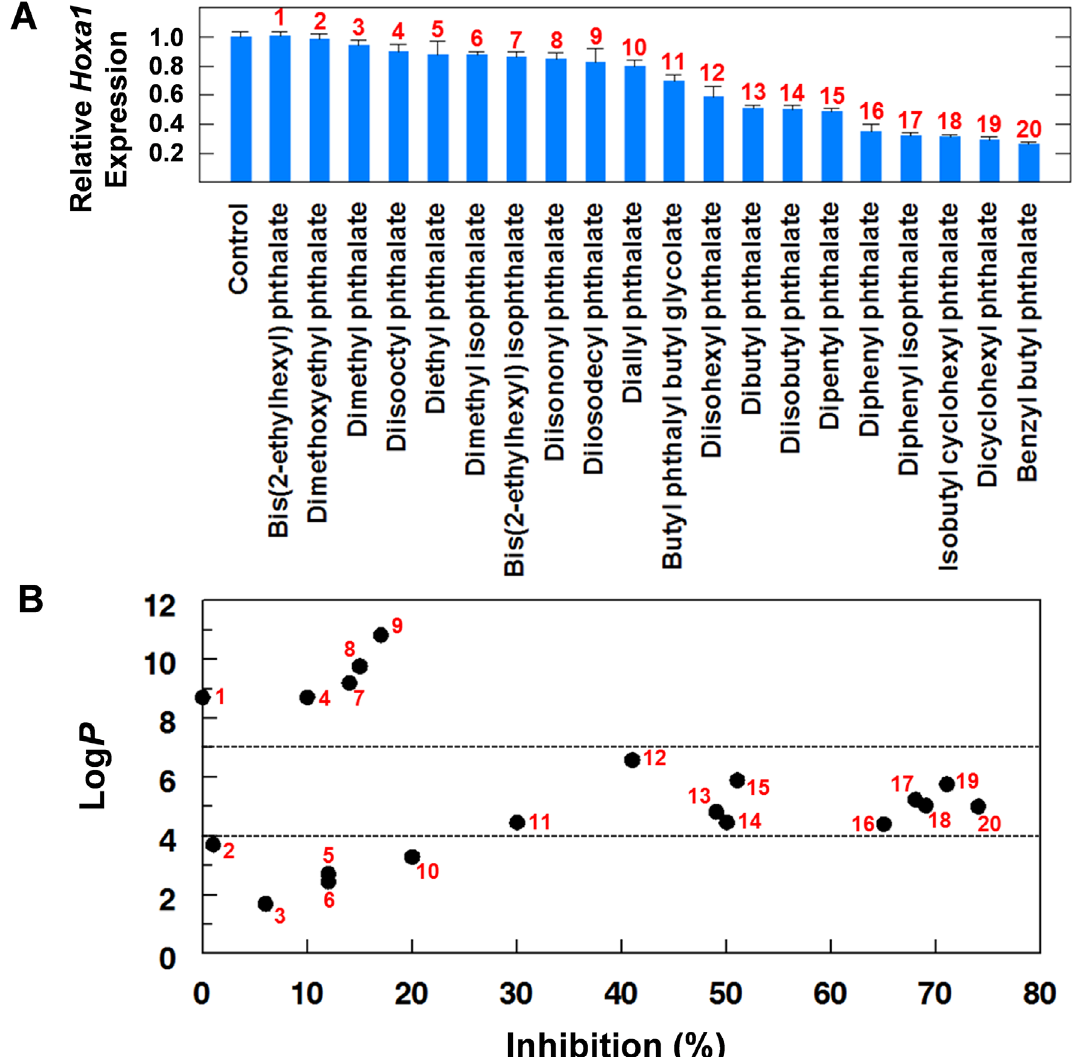
Fig 2. (A) Effect of PEs on the induction of Hoxa1 by ROH in the 7 h screen. Hoxa1 expression in PE-treated cultures was quantitated by RT-qPCR on cell lysates [11] and normalized to Hoxa1 expression in ROH-only treated control cultures. The data are arranged according to increasing relative inhibitory activity. Values are Means ± SEM; n (cid:1) 8. (B) Relationship between log P and RSP inhibition by PEs for data shown in A. Horizontal dashed lines bracket the log P range containing the most inhibitory PEs. Log P s are calculated values obtained from the ChemSpider web site (http://www.